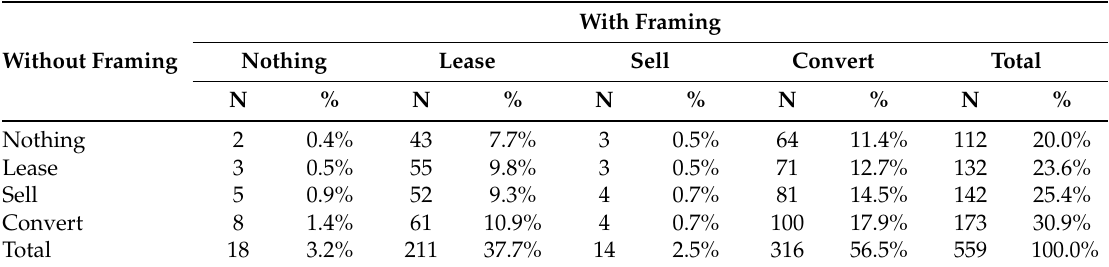
Table 2. Sharply contrasting choices in unframed vs. framed risk games. With